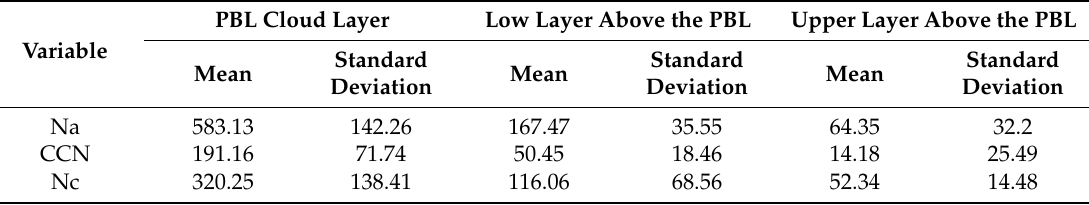
Table 1. The mean and standard deviations (std) of aerosol concentration (Na), cloud condensation nuclei (CCN) concentration, and cloud droplet number concentration (Nc) in PBL cloud layer, low layer above the PBL, and upper layer above the PBL for the three-layer stratus cloud measured over Huanghua, China on 26 April